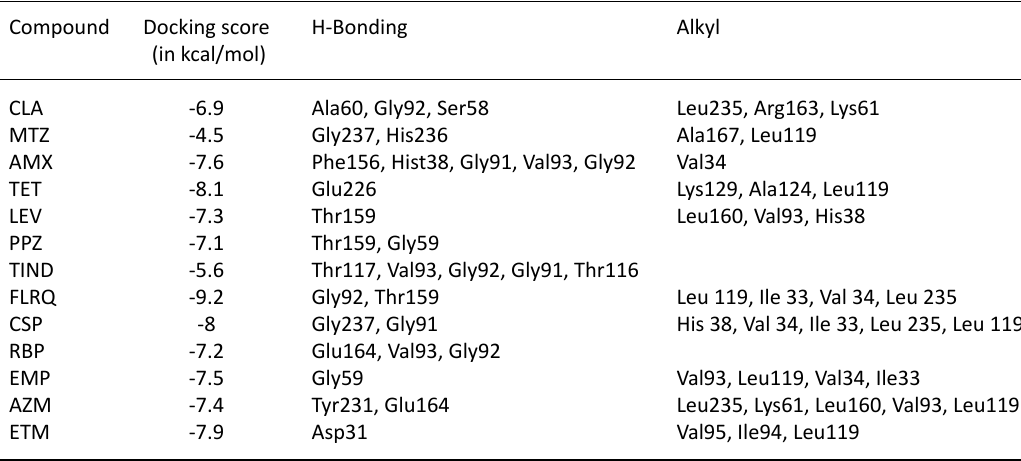
Fig. 1. Protein 1UFM and residues. (a) With 4 chain of 1UFM. (b) With 3 chain of 1UFM. (c) With 2 chain of 1UFM. (d) With (single chain of 1UFM( used for molecular docking Table 2. Molecular docking score and binding interactions of commercially available H. pylori drugs with Chorismate synthase protein of H. pylori